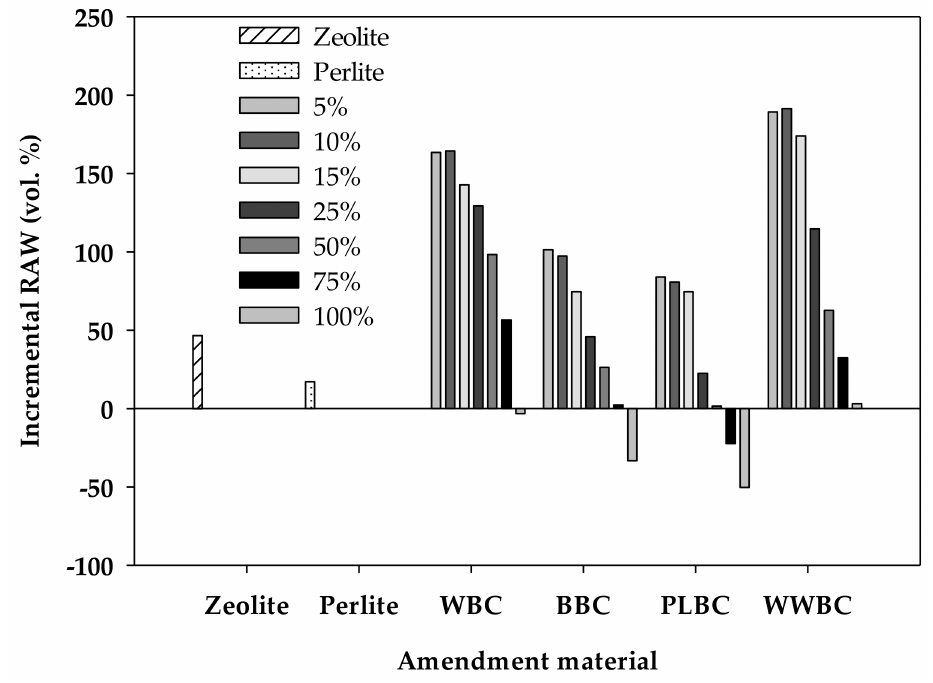
Figure 4. Effect of biochar type (woodchip biochar (WBC), bagasse biochar (BBC), poultry litter biochar (PLBC) and waterweed biochar (WWBC)), biochar application rate, zeolite and perlite on the incremental RAW capacity of sandy soil (%